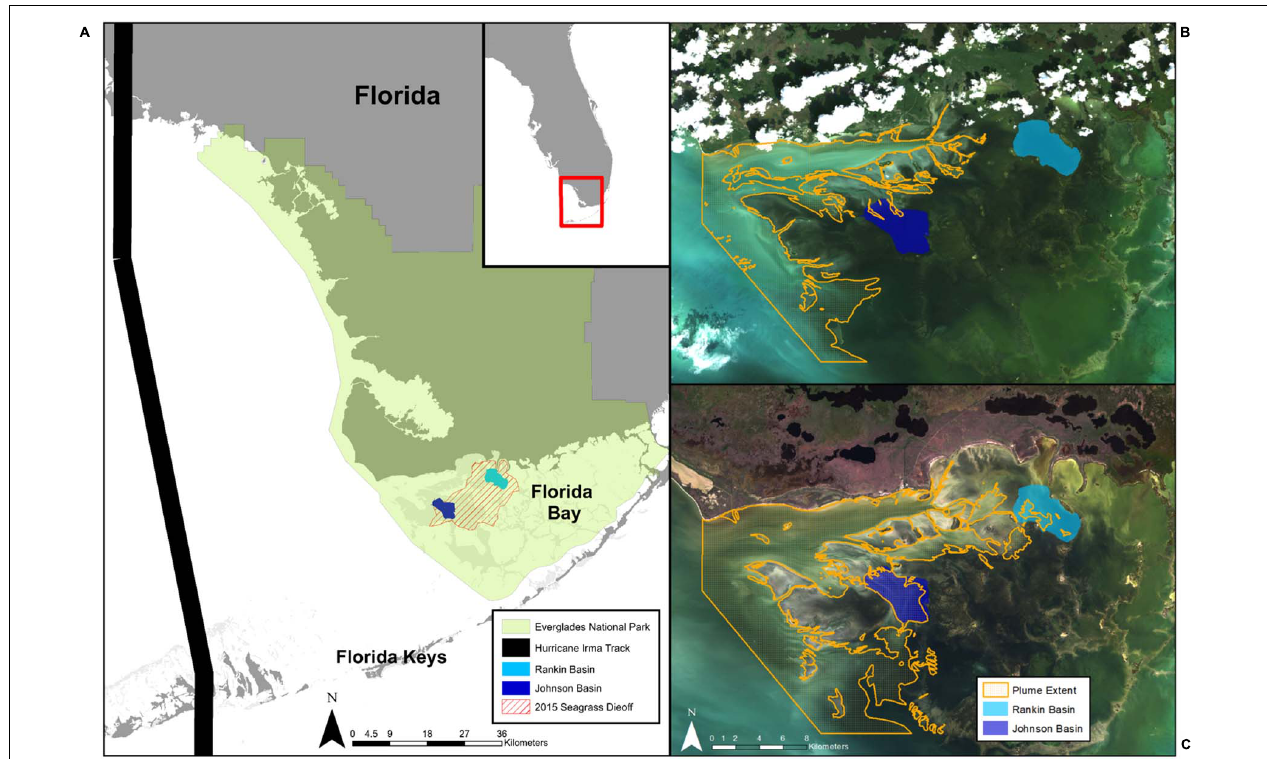
FIGURE 2 | (A) Map of Florida Bay showing the location of our two study basins (Rankin and Johnson), the extent of the 2015 seagrass die-off, and the track of Hurricane Irma in 2017. Everglades National Park is denoted by green shading. Extent of the sediment plume overlaid over satellite imagery shows the (B) smallest (119.6 km 2 ; 10/03/2009), and (C) largest plume areas (249.2 km 2 ; 11/29/2018) observed in the